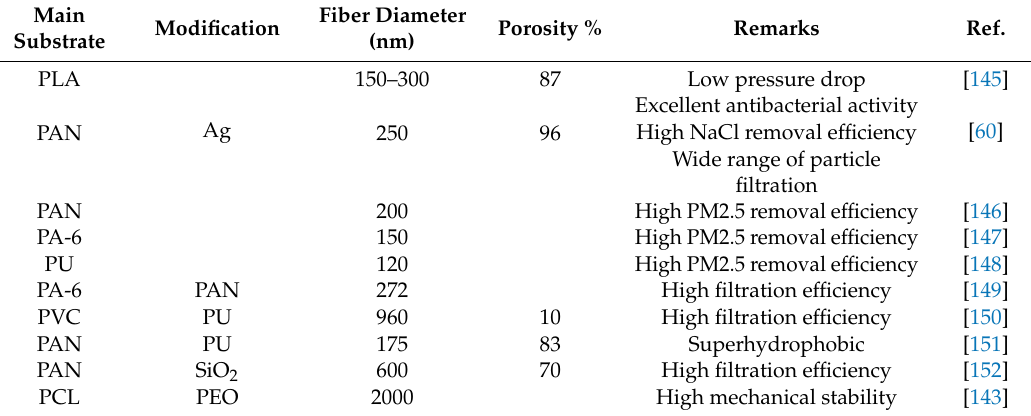
Table 2. Various electrospun nanofibers used in air